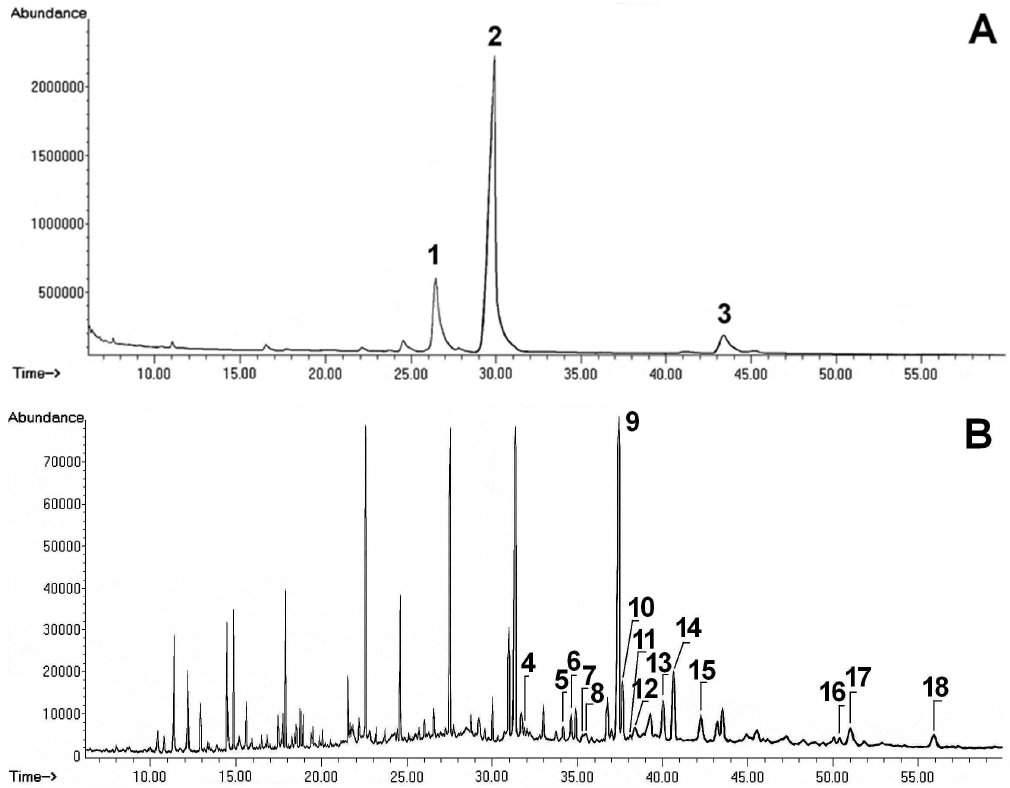
Figure 1. Representative GC-FID chromatograms of the fraction containing methyl esters of triterpene acids ( A ) and the fraction containing sterols and neutral triterpenes ( B ) obtained from apple pomace. Peaks are numbered according to the retention times: ( 1 ) oleanolic acid (methyl ester), ( 2 ) ursolic acid (methyl ester), ( 3 ) pomolic acid (methyl ester), ( 4 ) cholesterol, ( 5 ) cholesta-3,5-dien-7-one, ( 6 ) campesterol, ( 7 ) cholest-4-ene-3,6-dione, ( 8 ) stigmasterol, ( 9 ) sitosterol, ( 10 ) isofucosterol, ( 11 ) cycloartanol, ( 12 ) β-amyrin, ( 13 ) α-amyrin, ( 14 ) stigmasta-3,5-dien-7-one, ( 15 ) sitostenone, ( 16 ) ursolic aldehyde, ( 17 ) erythrodiol, ( 18 ) uvaol. Peaks not numbered are associated with aliphatic or phenolic compounds.